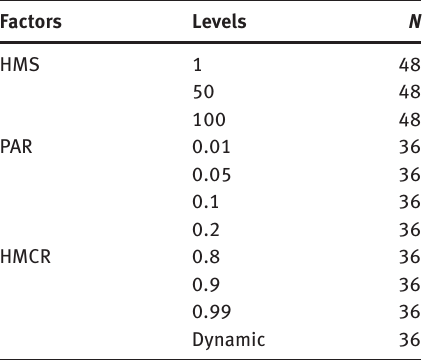
Table 4: Experimental Factors and Their Levels.